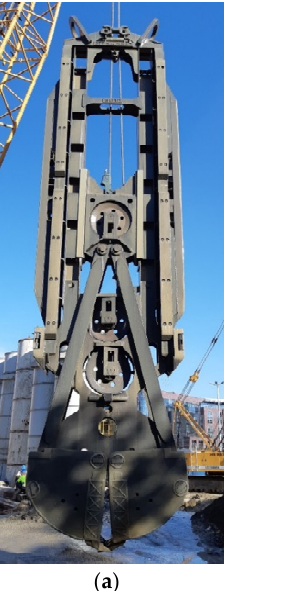
Figure 4. Photos from the construction site: ( a ) Cutter excavation machine; ( b ) The influence of technology on the concrete surface.